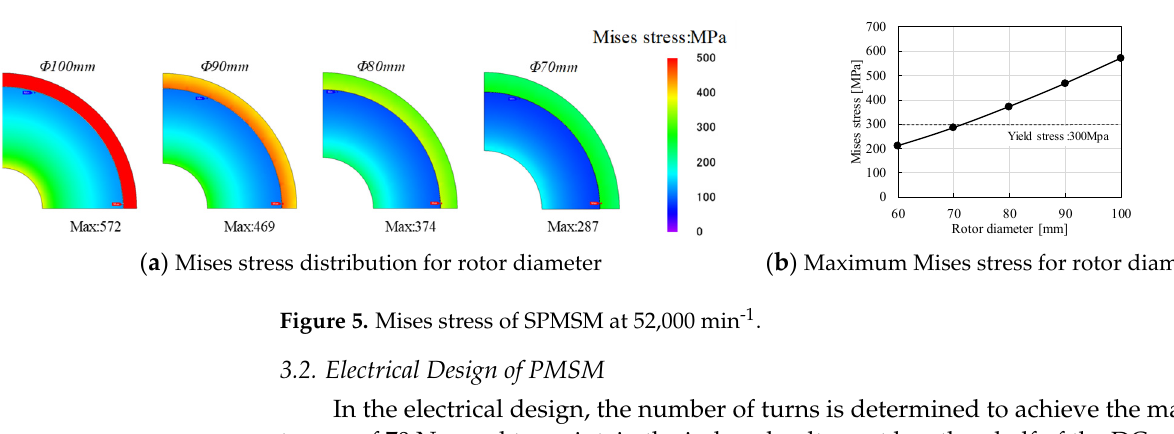
Figure 4. Mises stress in the rotor for IPM type (Model A and Model B) and SPM type.